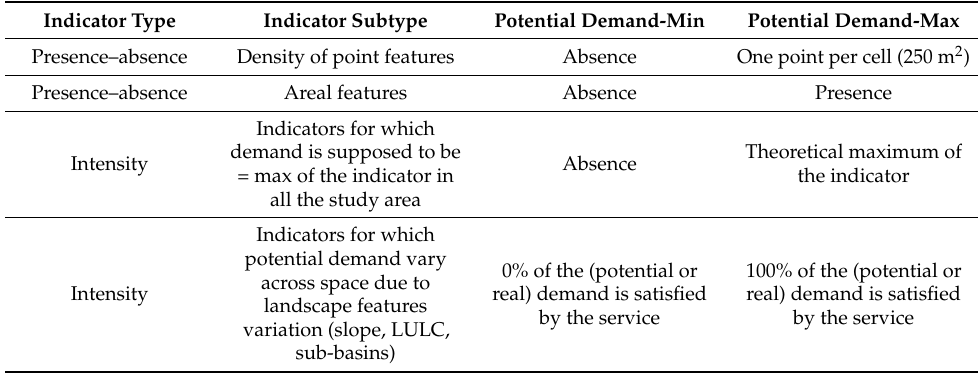
Table 3. Approaches used for demand-based scaling of the ecosystem and urban services’